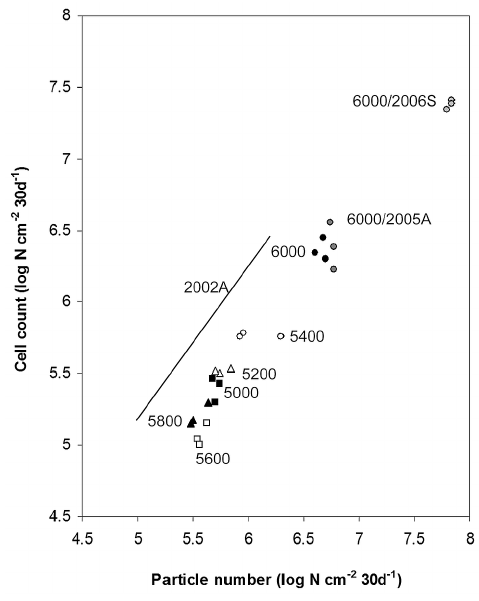
Figure 6. The relationship between dust particle number and N microbial abundance during 2002, 2005 and 2006 sampling ) 6000 m, ( m ) 5800 m, ( % ) 5600 m, ( # ) 5400 m, (?) campaigns. ( 5200 m, ( & ) 5000 m. ( ) 6000 m autumn 2005; ( ) 6000 m spring 2006.